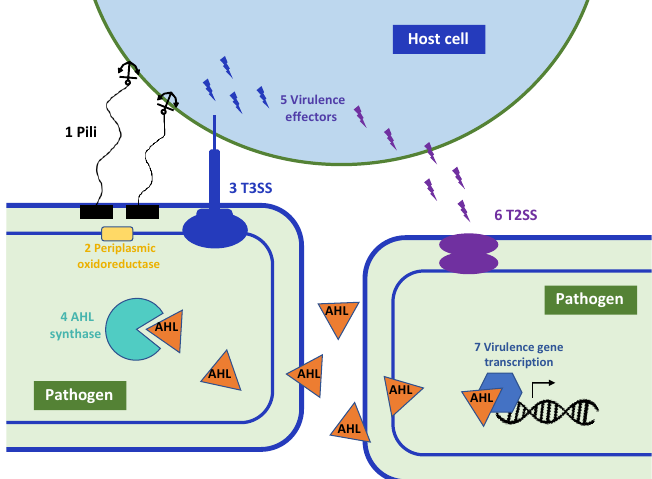
Figure 1. Overview of bacterial virulence pathways that have been targeted for inhibition via SBDD. Pathogen adhesion to the host cell; 1. Inhibitors of pili biogenesis and assembly (e.g., chaperone/usher pathway). Folding and disulfide bond formation in secreted virulence factors; 2. Inhibitors of periplasmic thiol oxidoreductase (e.g., DsbA). Virulence effector injection into the host cell; 3. Inhibitors of the type 3 secretion system (T3SS). Acyl homoserine lactone (AHL) quorum sensing signal generation; 4. Inhibition of AHL synthase (e.g., LasI). Effector protein toxicity; 5. Toxin neutralization to prevent host cell damage. Toxin protein secretion into the extracellular milieu; 6. Inhibitors of the type 2 secretion system (T2SS) to block toxin translocation across the outer membrane. Transcriptional activation of virulence genes in response to stress or quorum signals; 7. Inhibitors of AHL binding to cognate transcription regulators (e.g., LasR).